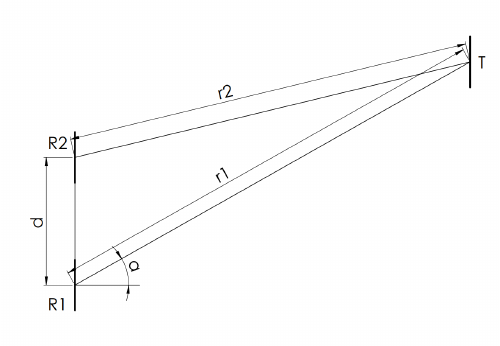
Figure 2. A direct measurement with one transmitter and a two-element vector receiver